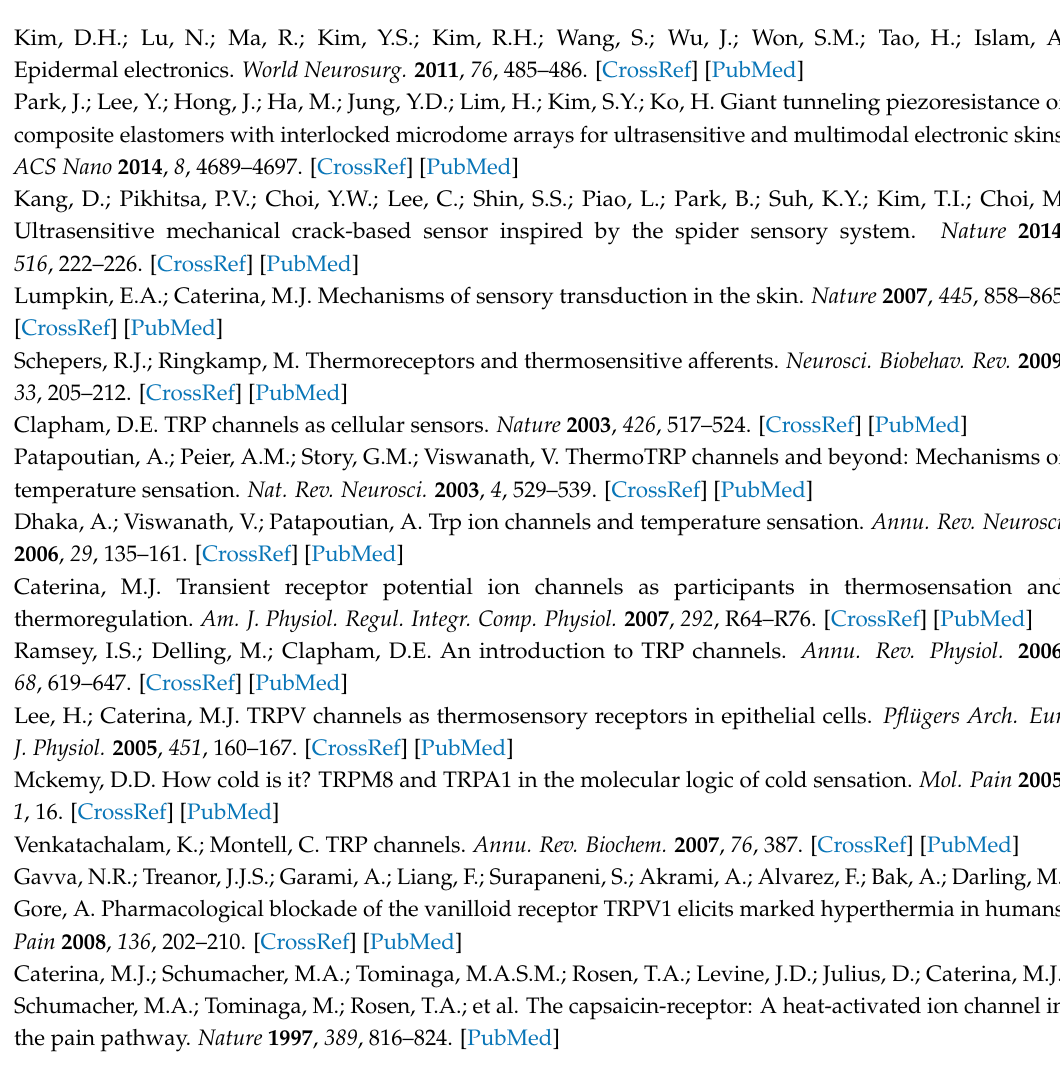
Figure S1: Illustration of measurement setup and principle for the locations of sensory spots. Table S1: Physical Characteristics of